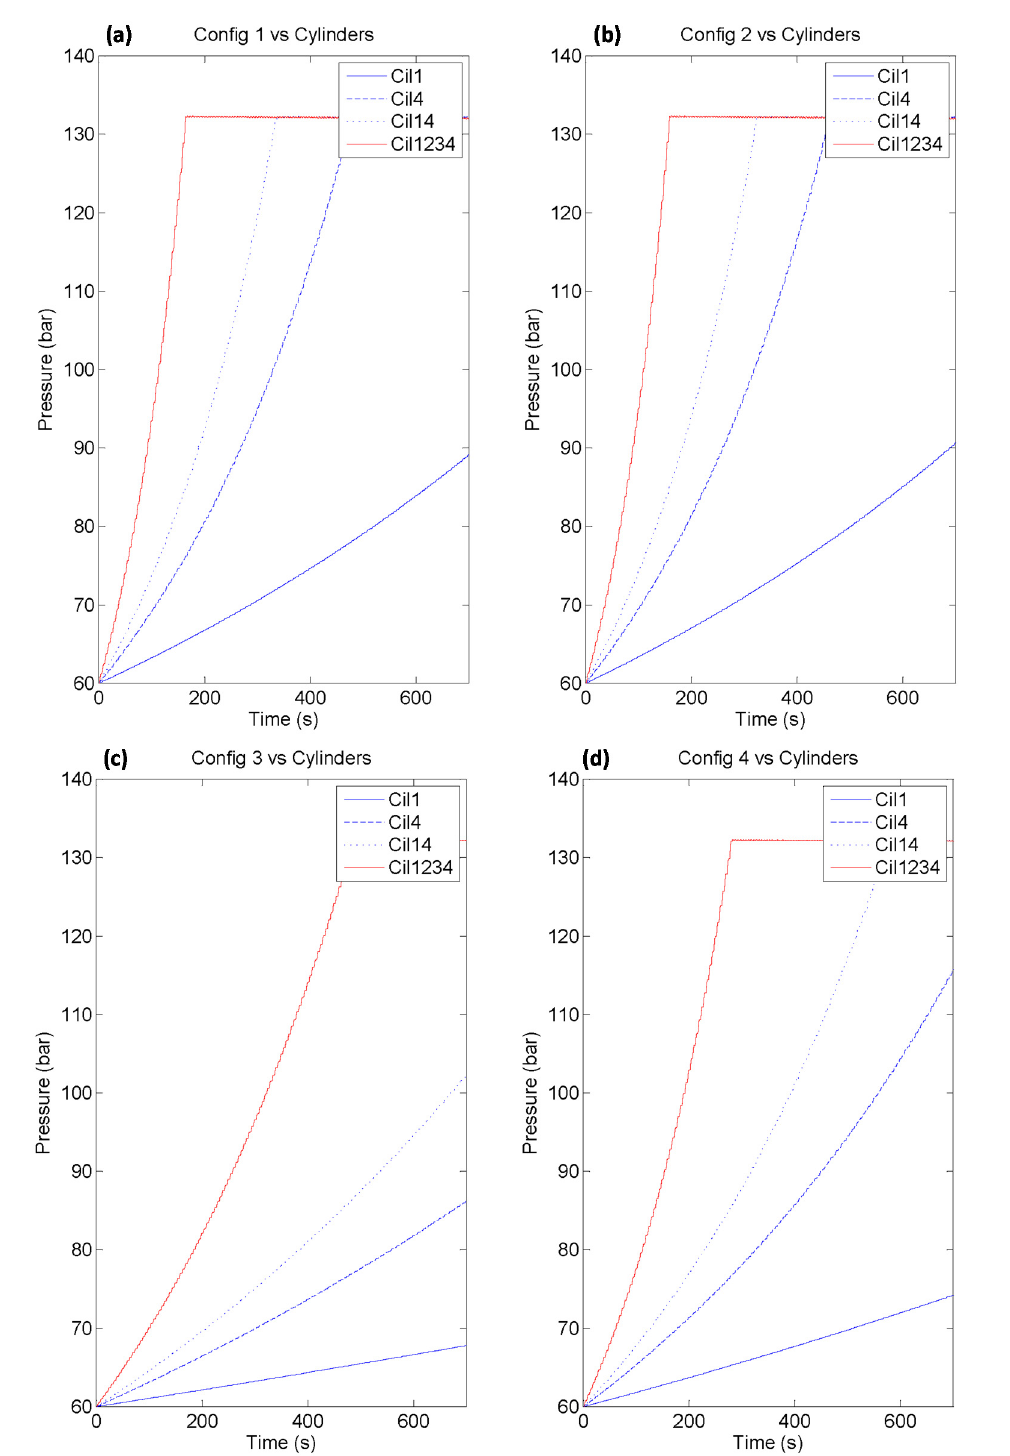
Figure 14. High Pressure accumulator pressure evolution related to the active hydraulic cylinders, with a fixed specific geometrical configuration. ( a ) Config 1; ( b ) Config 2; ( c ) Config 3; ( d ) Config